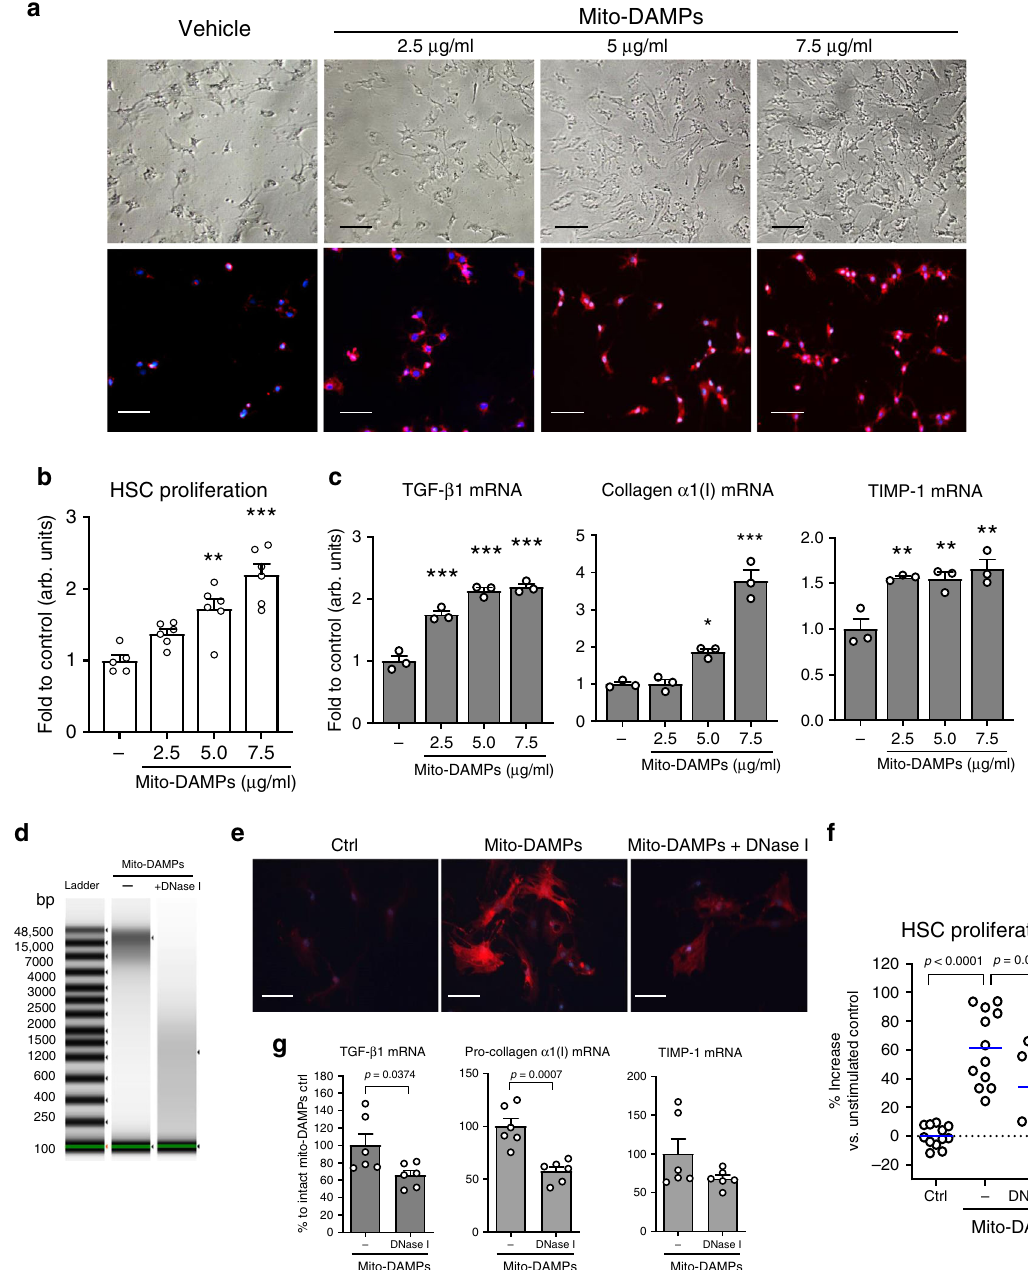
Fig. 6 Hepatocyte-derived mito-DAMPs directly trigger fi brogenic activation of primary hepatic stellate cells, with mtDNA as a major active component. Freshly isolated murine HSCs were incubated for 24 h in vitro with increasing concentration of mito-DAMPs (corresponding to 2.5 – 7.5 μ g of intact mtDNA/ml) prepared from puri fi ed liver mitochondria. a Changes in HSC morphology upon mito-DAMPs exposure (upper panel, phase contrast